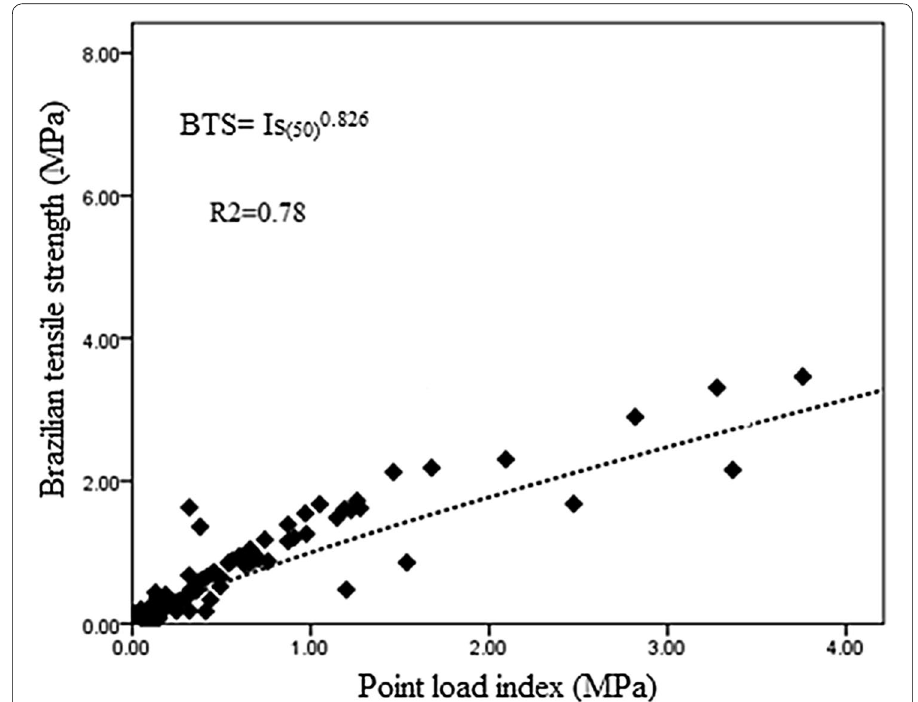
Fig. 2 The relation between I s(50) and